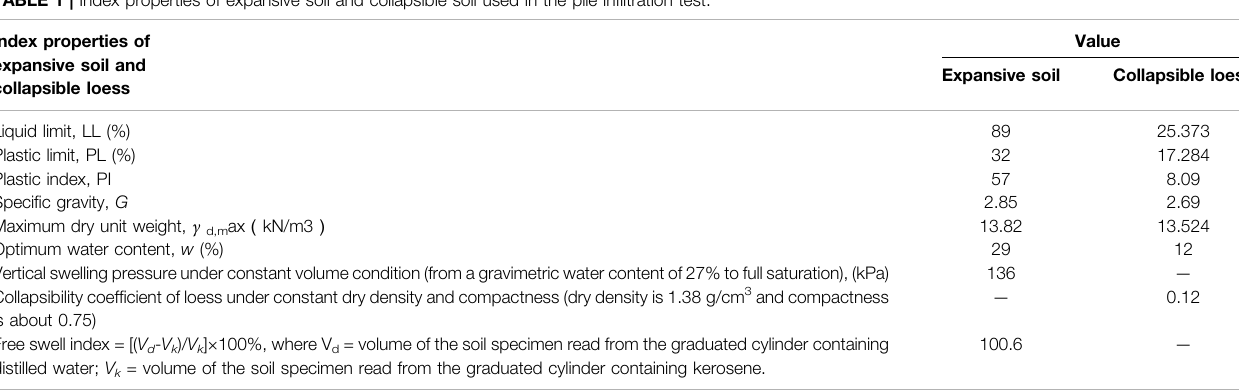
TABLE 1 | Index properties of expansive soil and collapsible soil used in the pile in fi ltration test. Index properties of expansive soil